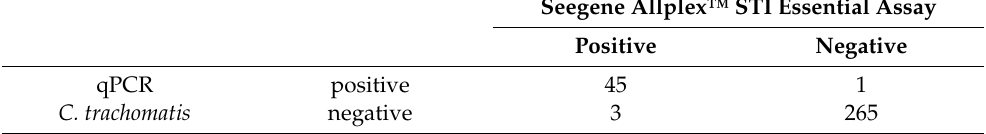
Table 1. Comparison of the performance of the Seegene Allplex™ STI Essential Assay and of our routine C. trachomatis qPCR. Please note the excellent congruent results obtained, with an overall agreement of 98.7%